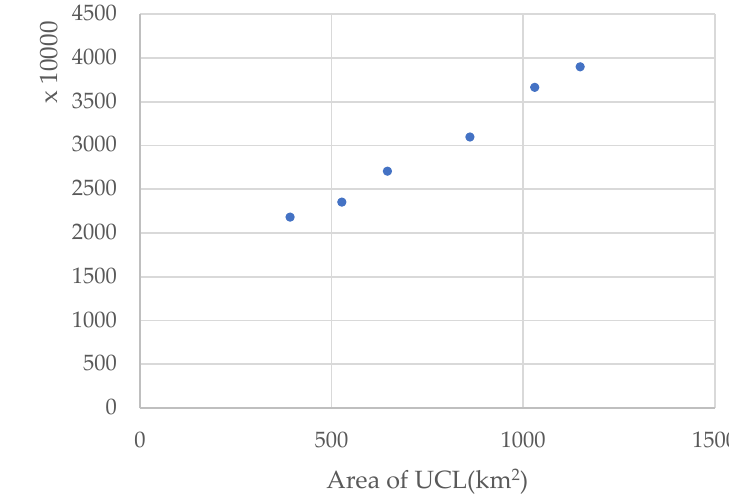
Figure 7. Changes in UCL and carbon emissions, 1995–2019. Table 8. Summary of curve estimation models and parameter estimates.